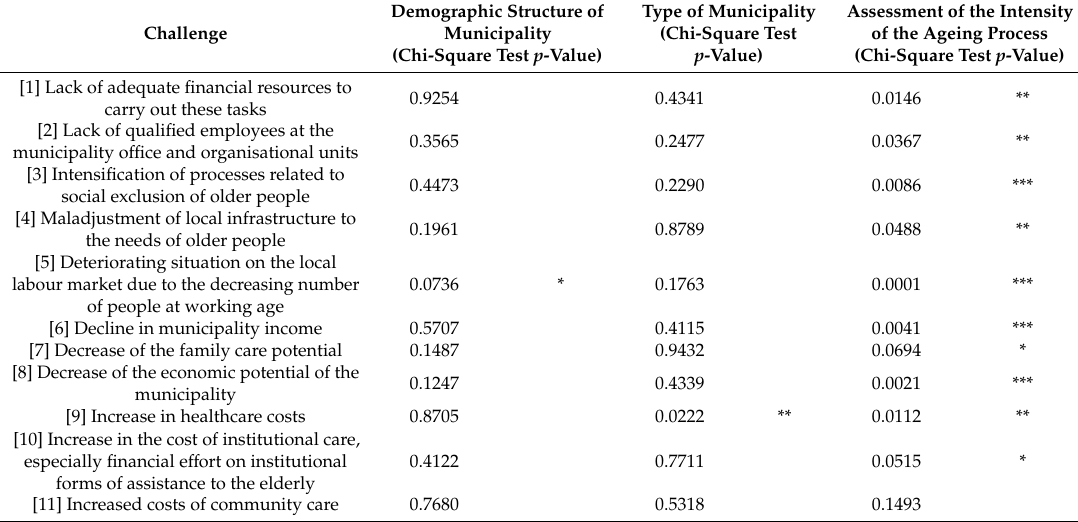
Figure 5. Surveyed municipalities opinion on the challenges related to the population ageing by demographic structure, type of municipality and subjective assessment of the intensity of the ageing process. Note: [1] Lack of adequate financial resources for the implementation of these tasks; [2] Lack of qualified employees at the municipality office and organisational units; [3] Increased processes related to social exclusion of older people; [4] Maladjustment of local infrastructure to the needs of older people; [5] The deteriorating situation on the local labour market due to the decline in the number of people at working age; [6] Decrease in municipality income; [7] Decrease of family care potential; [8] Reduction in the economic potential of the municipality [9] Increased health care costs; [10] Increase in the cost of institutional care; [11] Increased costs of community care. Table 4. The challenges related to population ageing in different types of local government units (LGUs) by demographic structure, type of municipality, and subjective assessment of the intensity of the ageing process.